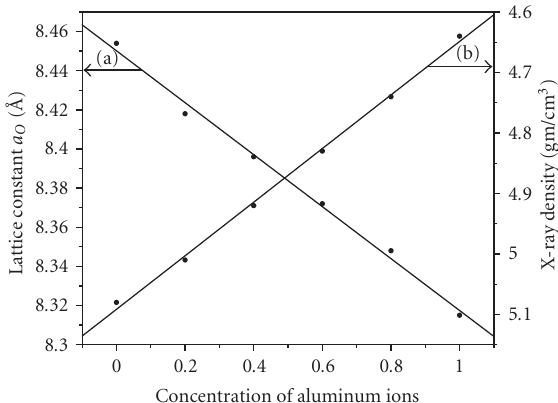
Figure 2: Variation of (a) lattice constant and (b) X-ray density with aluminum ions